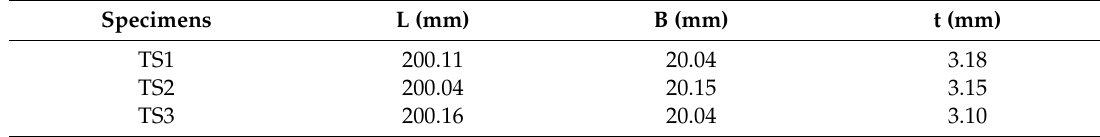
Table 2. Geometric parameters of specimens.